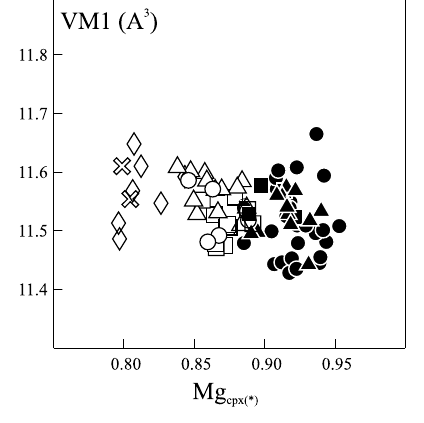
Fig. 11 – Variation in VM1 vs. Mg cpx(*) for clinopyroxenes from the Janjão, Pandolfo and Lambedor diatremes. Mg cpx(*) = Mg/(Mg+Fe 2+ ). Symbols as in Fig. 2.